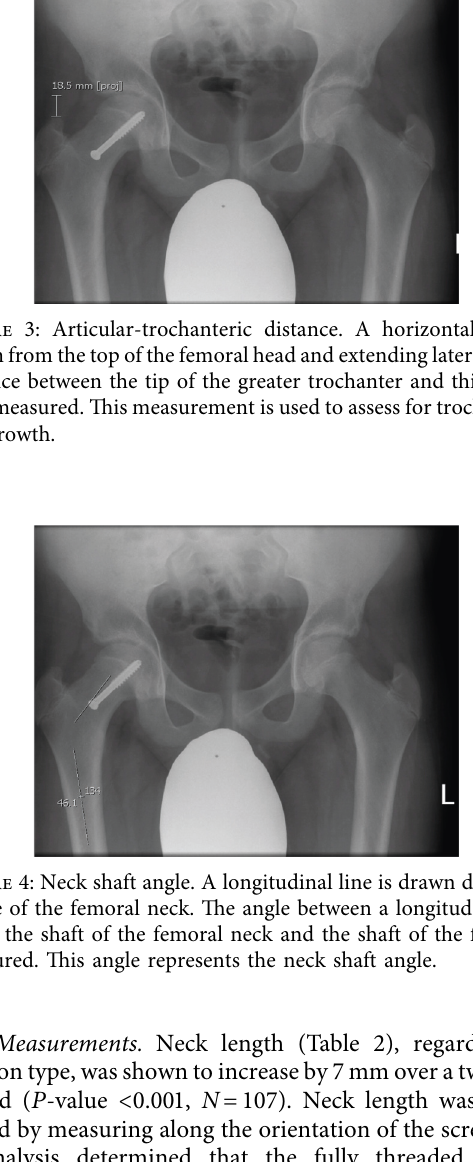
Table 1: Demographic information on patient cohort.